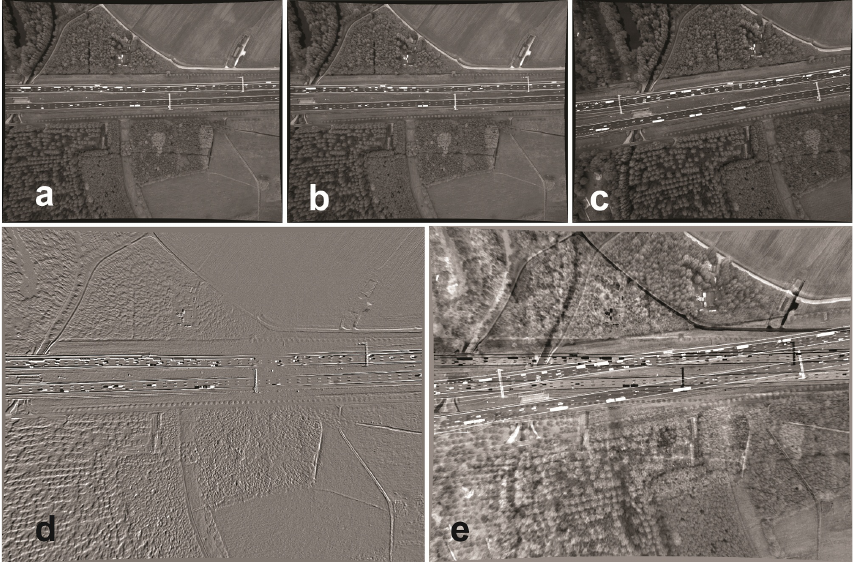
Figure 1. Difference images before registration: ( a ) the first image; ( b ) the second image; ( c ) the 800 th image; ( d ) the first image subtracted from the second image; ( e ) the first image subtracted from the 800 th